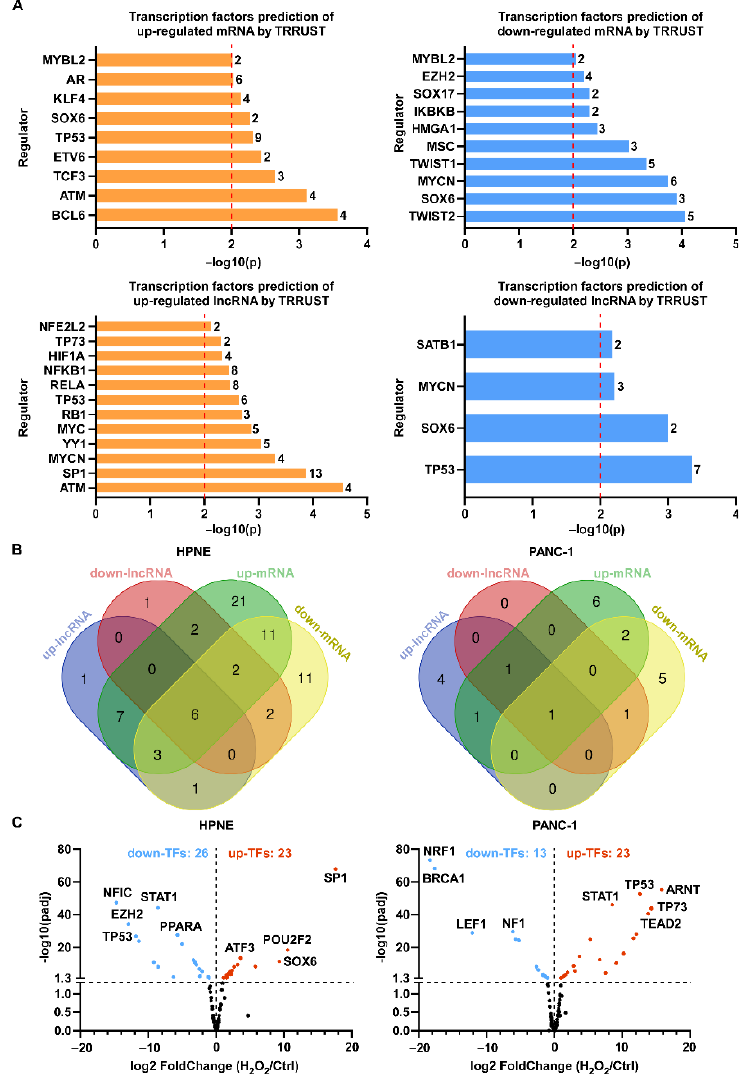
Figure 6. Transcription factors revealed by TRRUST analysis in HPNE and PANC-1 cells treated with H 2 O 2 . ( A ) Top transcription factors ( − log 10 ( p ) > 2) of up- and downregulated lncRNA ( top ) and mRNA ( bottom ) transcripts upon H 2 O 2 treatment in both cell lines were analyzed by TRRUST, and the counts of transcription factors are presented after the column. ( B ) Venn diagram showing all transcription factors predicted by TRRUST in HPNE ( left ) and PANC-1 ( right ) cell lines; the transcription factors are listed in Table 2 for HPNE cells and Table 3 for PANC-1 cells. ( C ) Volcano plots showing the mRNA levels of transcription factors predicted by PROMO and TRRUST upon H 2 O 2 treatment in HPNE cells ( left ) and PANC-1 cells ( right ). Red dots represent the upregulated transcription factors (log 2 (fold change) > 1 and p adj < 0.05) upon H 2 O 2 treatment, while blue dots represent the downregulated transcription factors (log 2 (fold change) < − 1 and p adj < 0.05). We next explored the expression levels of transcription factors predicted by PROMO and TRRUST. There were 26 downregulated and 23 upregulated transcription factors in HPNE, and 13 downregulated and 23 upregulated transcription factors in PANC-1 upon H 2 O 2 treatment (Figure 6C). For potential prediction of RNA transcript regulation by H 2 O 2 , there seemed to be no direct correlation between the expression of transcription factors and differentially expressed RNA transcripts. For instance, SP1 was significantly upregulated upon H 2 O 2 treatment, but TRRUST predicted it could recognize promoters of upregulated and downregulated lncRNA and mRNA transcripts. TP53 was